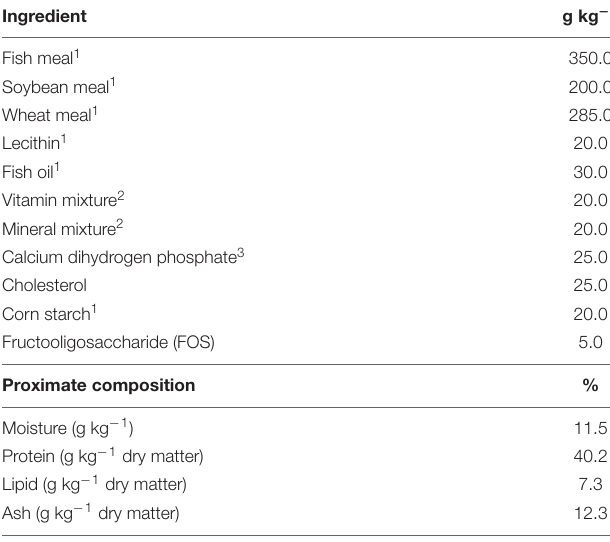
TABLE 1 | Ingredients and composition (% dry weight basis) of the control diet for whiteleg shrimp used in this study.